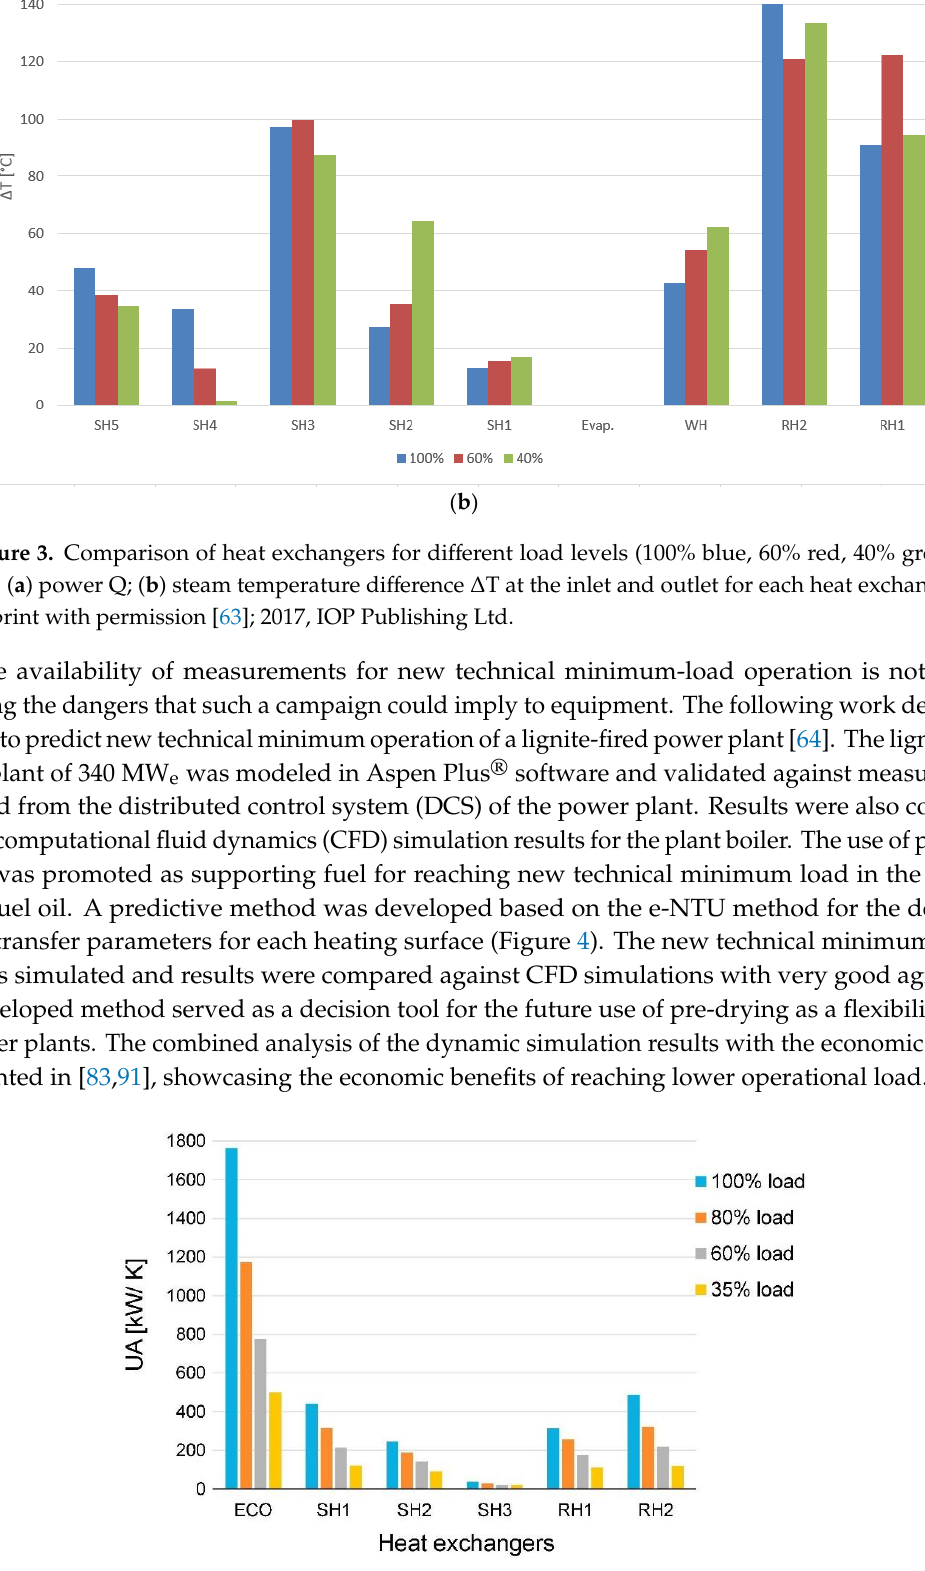
Figure 4. UA factor of boiler heat exchangers at various operation loads (100% blue, 80% orange, 60% grey, 35% yellow); Reprint with permission [64]; 2017,